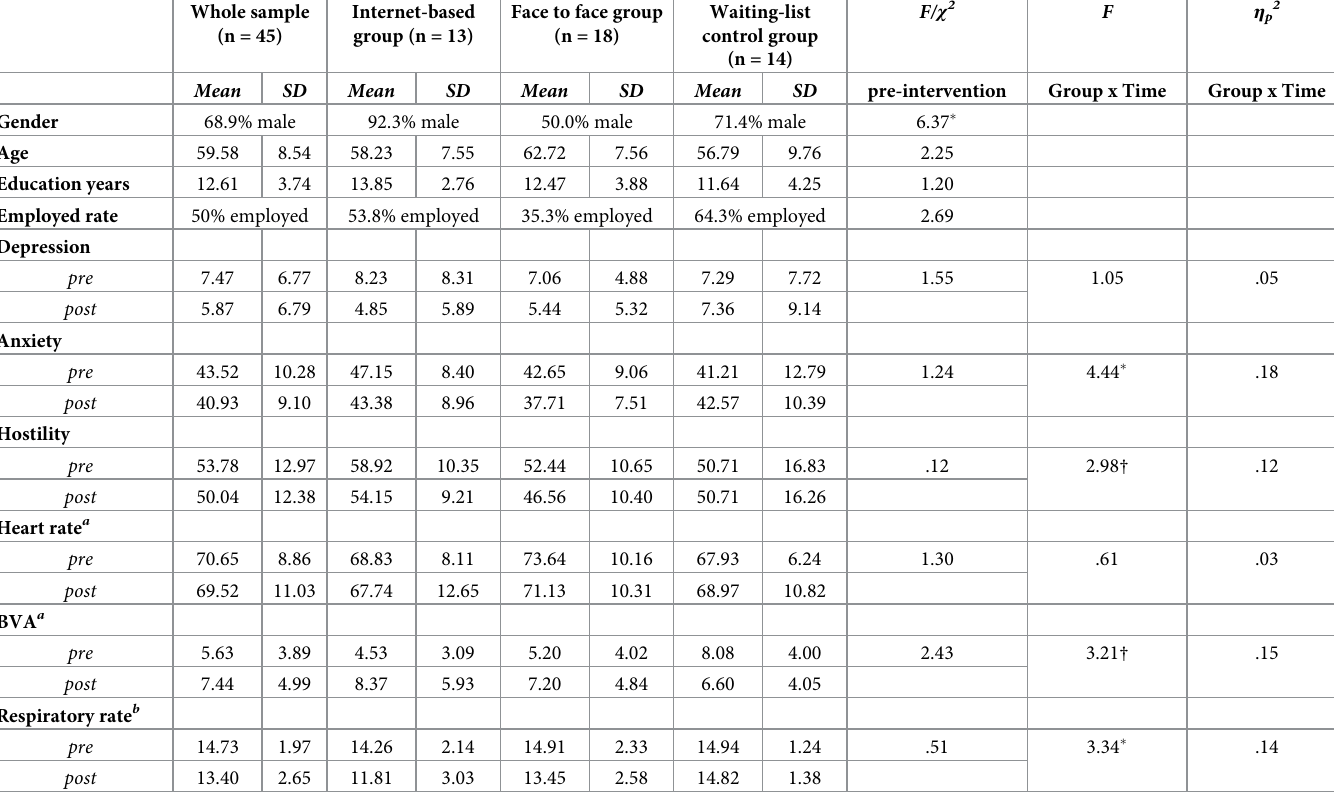
Table 2. Demographic data, psychological variables and the physical activities at preintervention and postintervention. Whole sample (n =